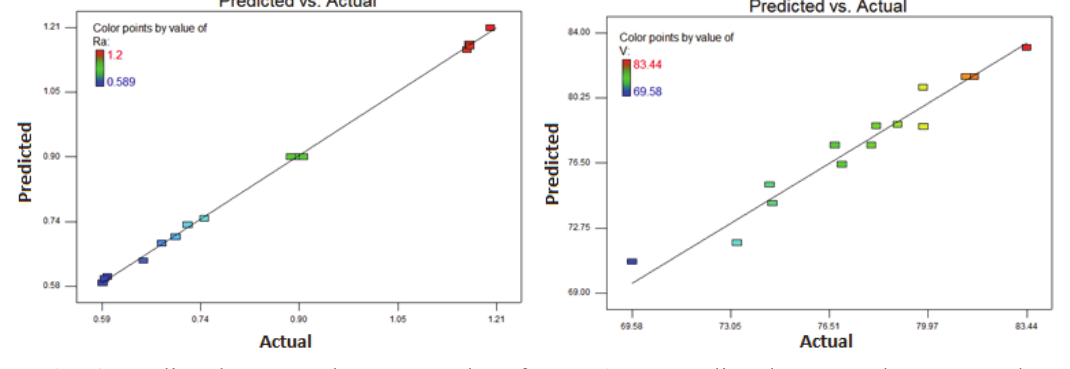
Fig. 4. Predicted vs. actual response plot of surface roughness